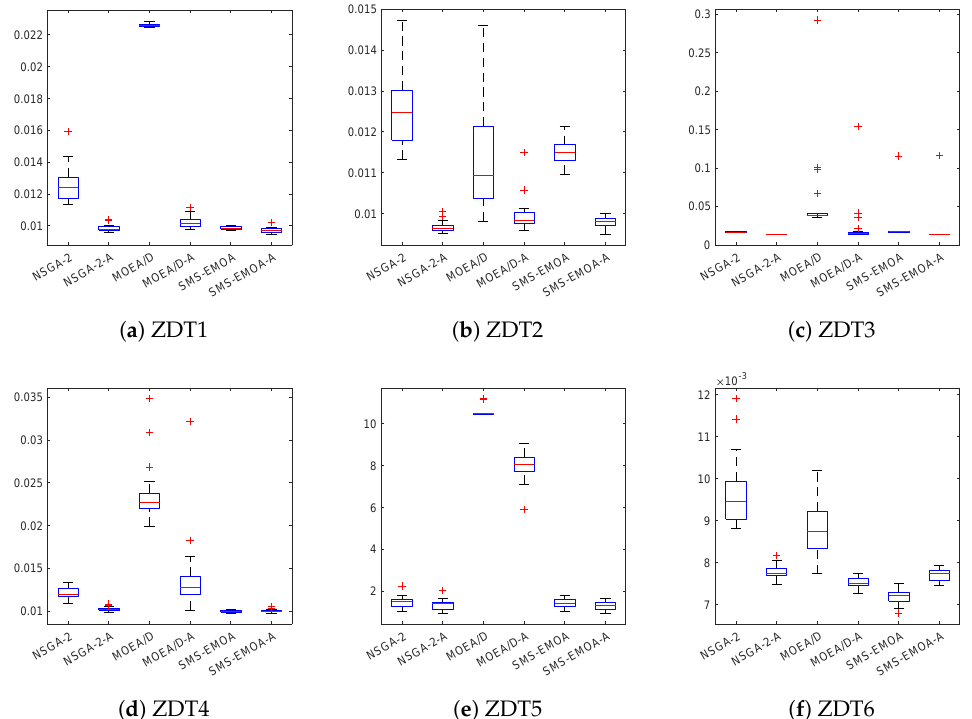
Figure 13. Boxplots for the obtained results for the ZDT test functions.